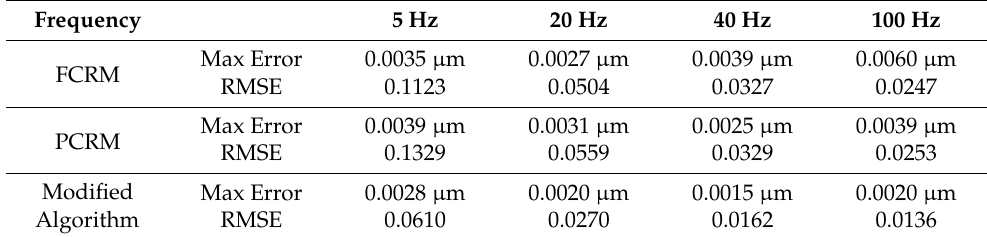
Table 2. Comparison of model performance